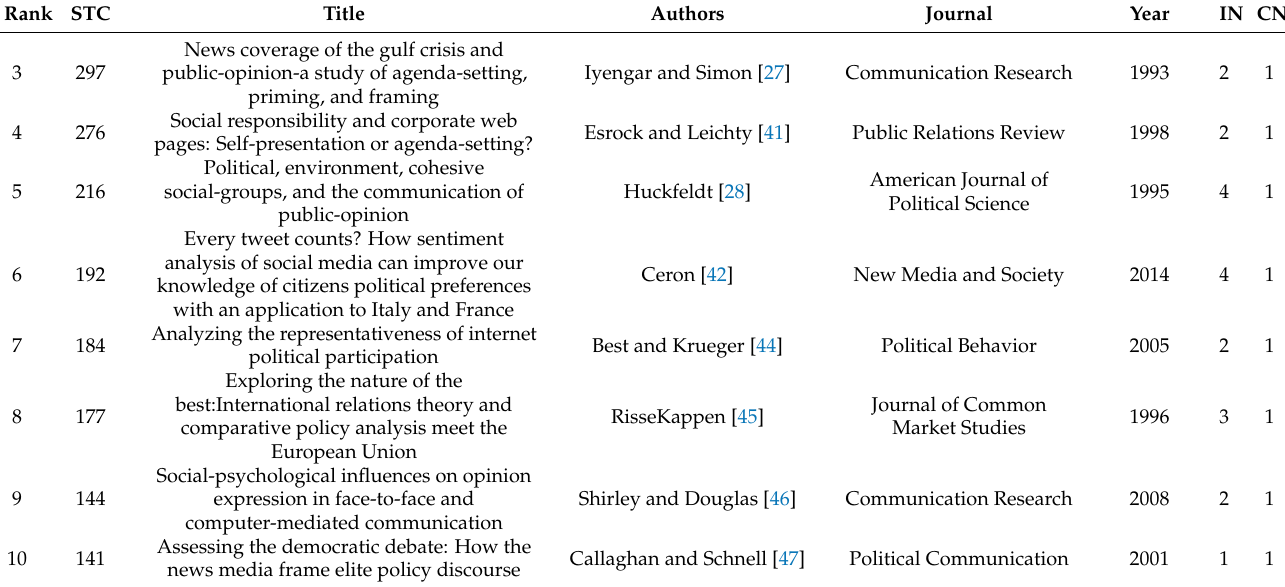
Table 6. Top 10 authors in NPO studies, 1990 – 2020.